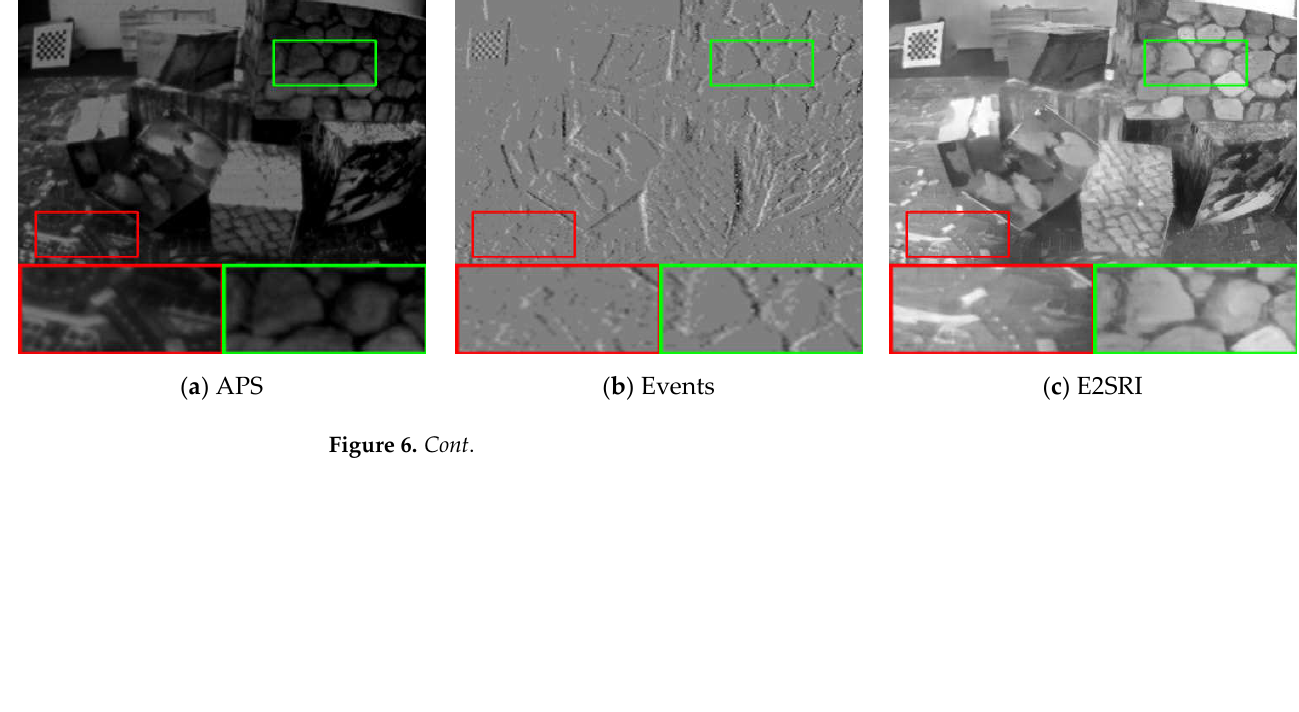
Figure 5. Comparison of the visual quality of our proposed method with other state-of-the-art methods for 4 × SR on synthetic datasets. The APS frame and event stack are upsampled with bicubic interpolation to the corresponding scale for reference.